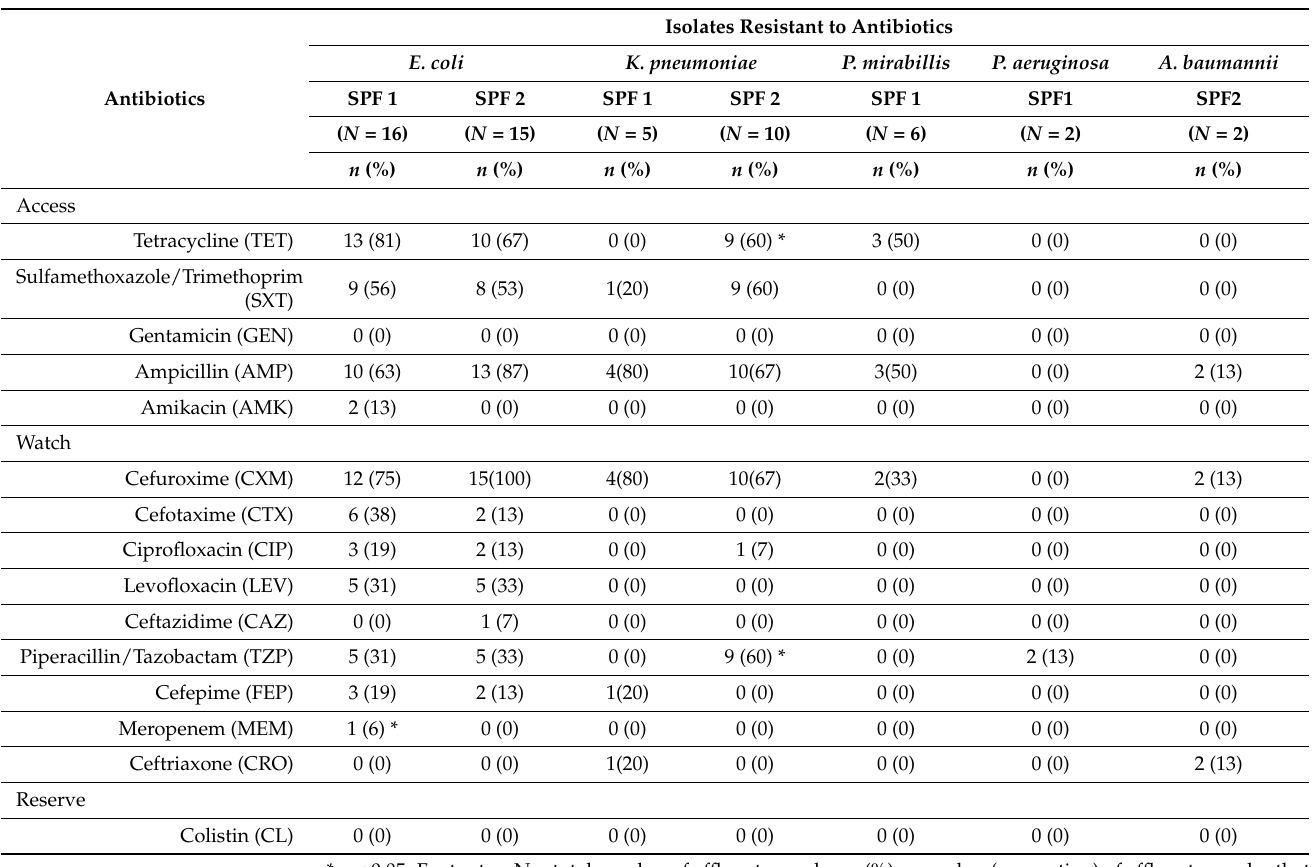
Table 3. Antibiotic resistance patterns for Gram-negative bacteria species of significance to surveil- lance, which were isolated from effluent samples in two seafood processing facilities (SPF) in Tema, Ghana during 2021 and 2022.